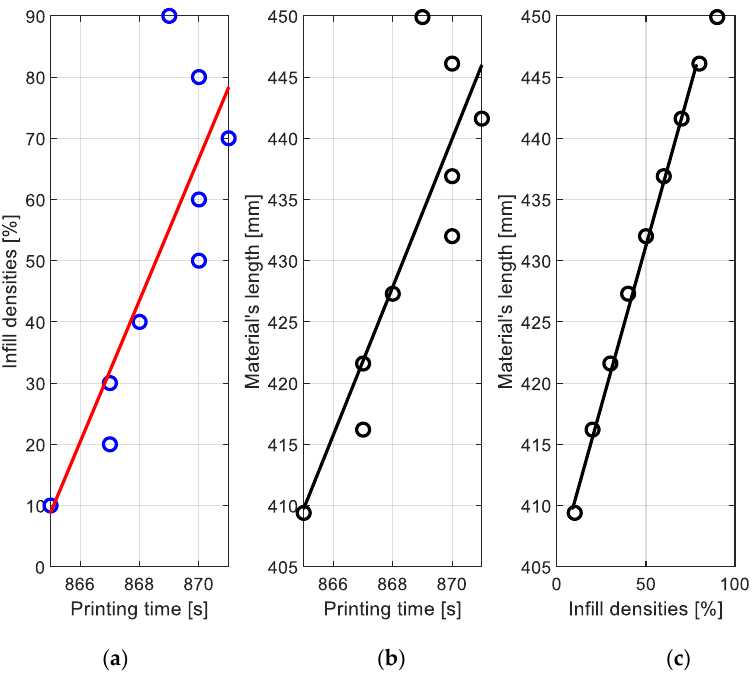
Figure 2. 2D plots of: ( a ) infill density vs. printing time, ( b ) material’s length vs. printing time, ( c ) infill density vs. the material’s length. Circles are experimental results and full line is the interpolation